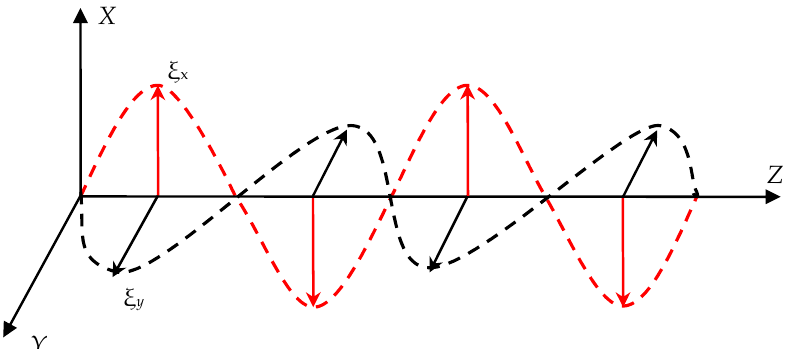
Figure 2. The superposition of two mutually perpendicular projections of the displacement vector ξ .